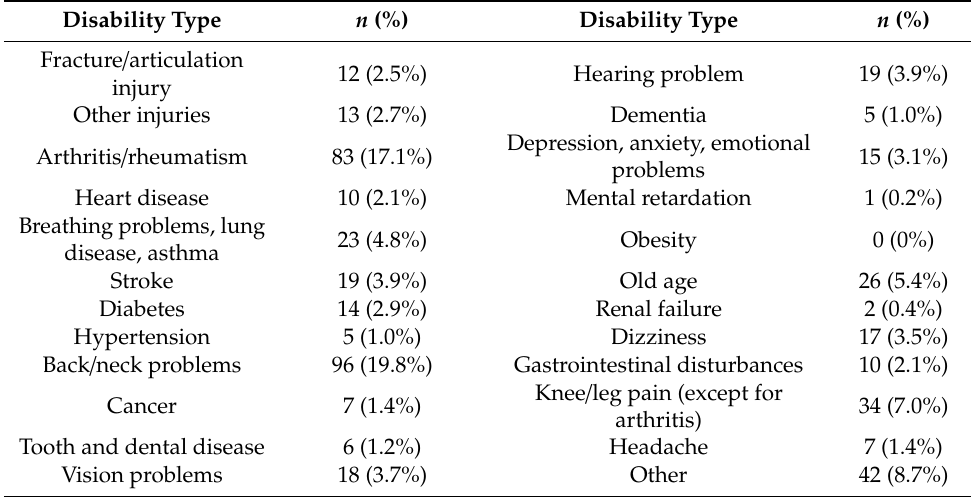
Table 3. Medical category frequencies among elders with